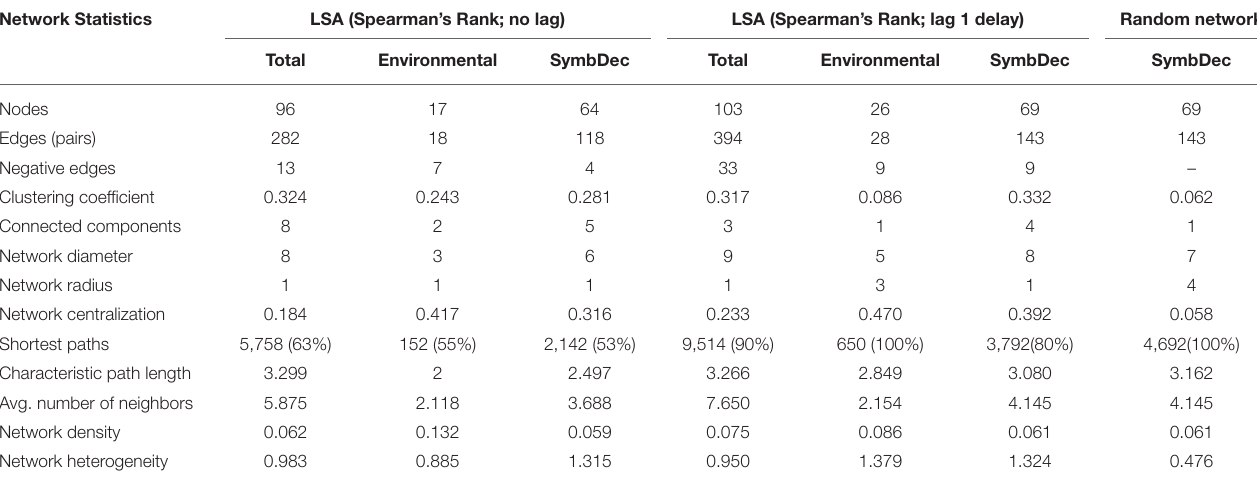
TABLE 2 | Network statistics of the LS analysis without lag and with lag delay of 1 time point, (a) for the total community including environmental variables, (b) for the connections only with environmental variables, and (c) the connections of SymbDec. Network